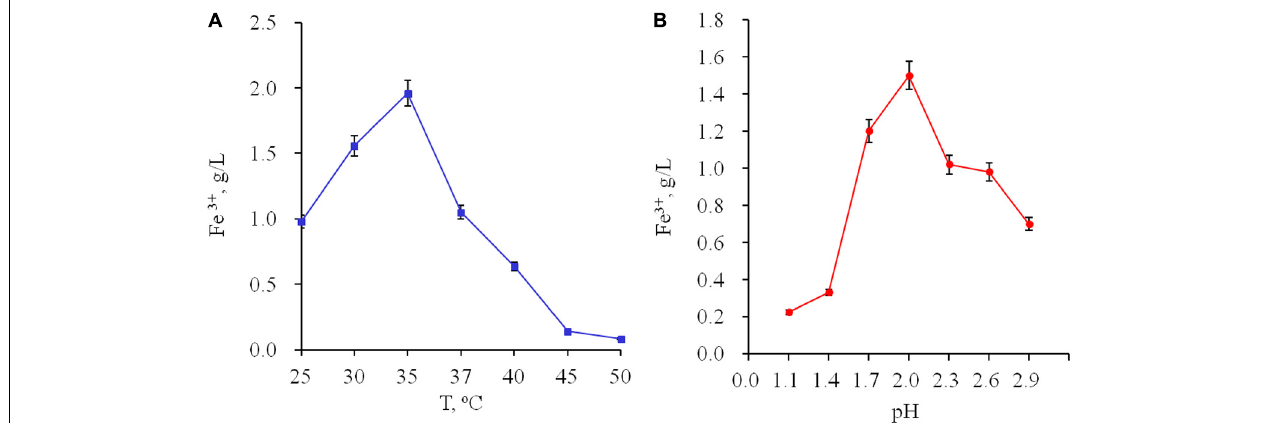
FIGURE 1 | Influence of temperature (A) and pH (B) on oxidation of ferrous ions by Acidithiobacillus sp.